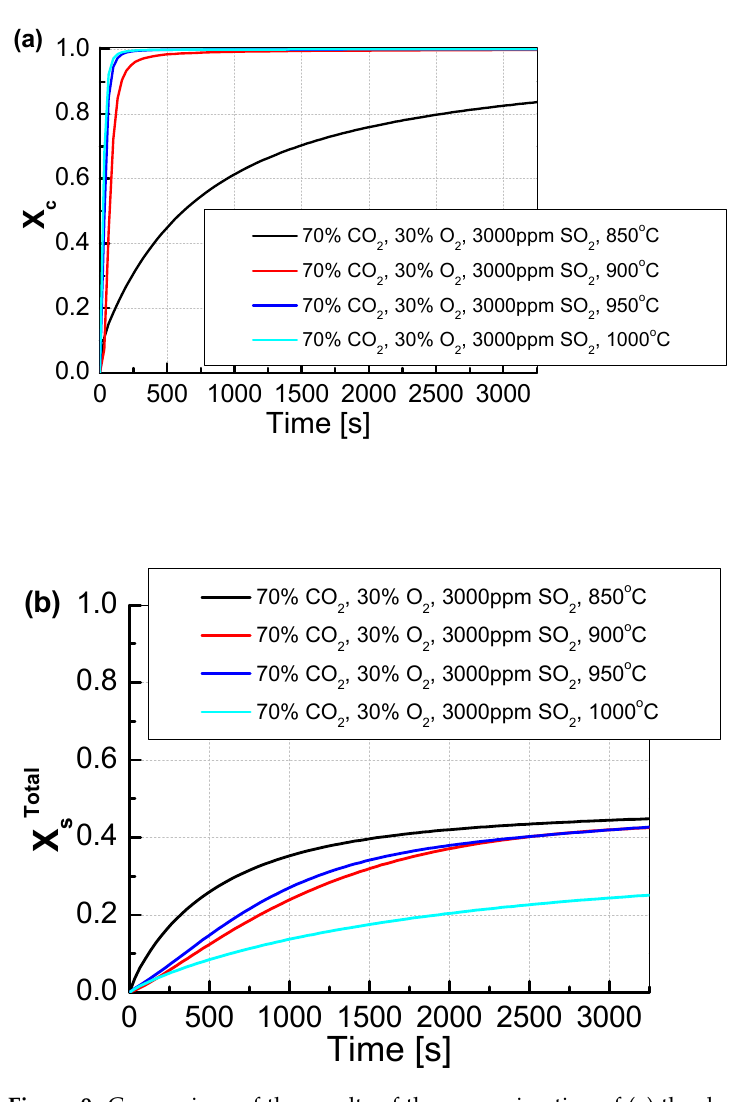
Figure 9. Comparison of the results of the approximation of ( a ) the degree of calcination X c and ( b ) the total degree of X s Total sulfation determined depending on the volume fraction of CO 2 in synthetic exhaust containing 70% CO 2 and 3000 ppm SO 2.